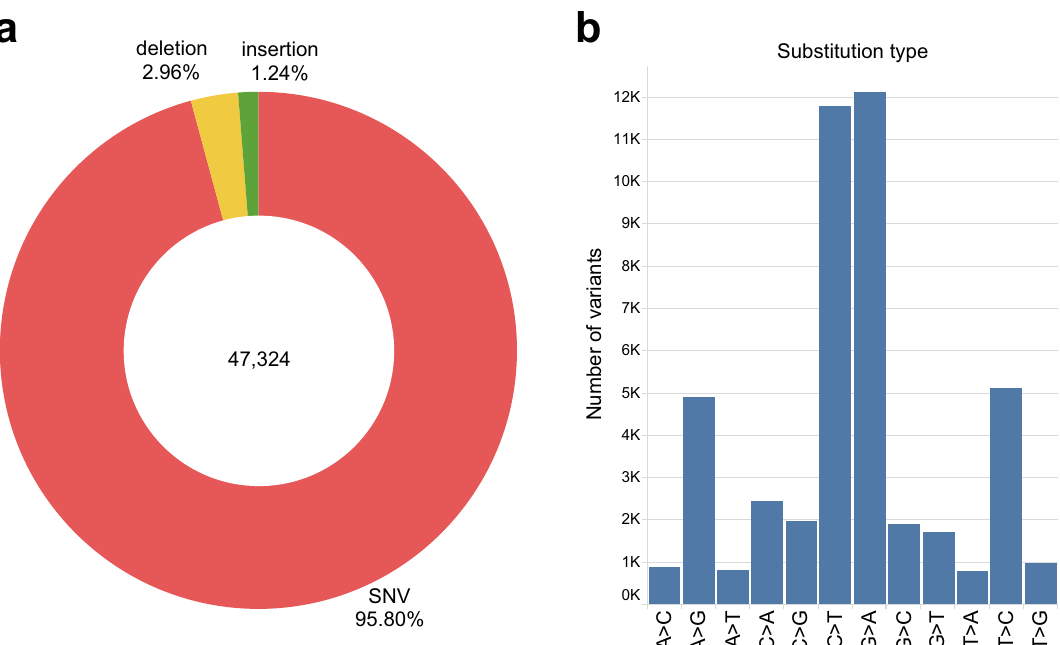
Figure 1. Serbian population sample variant classes and types. (a) Variant distribution by class shows that the vast majority of the total number of variants (47,324) are SNVs, followed by a significantly lower percent of deletions and insertions ( b) SNV substitution type